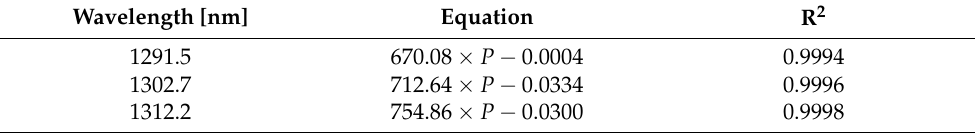
Table 1. Linear equations and R 2 values for three wavelengths, with P the optical power in watts.